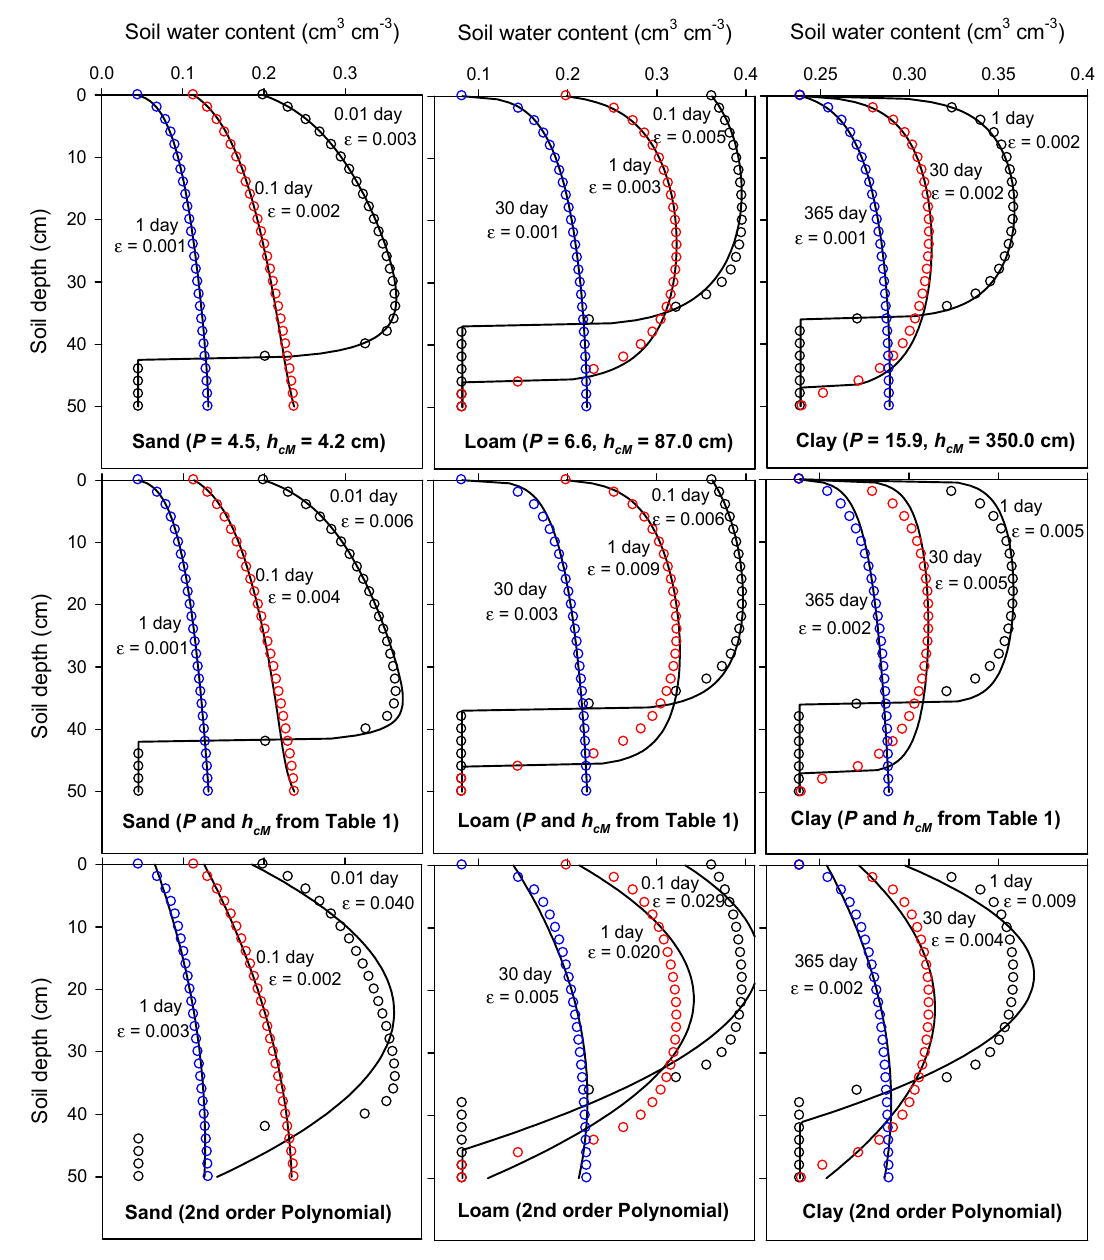
Figure 1. The best fit of Equation (21) (solid lines) to HYDRUS-1D simulation results (circles) for simultaneous evaporation and drainage in three different soils. The soil parameters in Equation (21), P and h cM , were treated as fitting parameters (top row), taken from Table 1 (middle row), or were set to P = 1 and h cM >> 50 cm leading to the second order polynomial (bottom row). Data below the wetting front were not considered for least square fitting. The fitting accuracy is quantified with the mean absolute error, ε (cm 3 cm − 3 ).